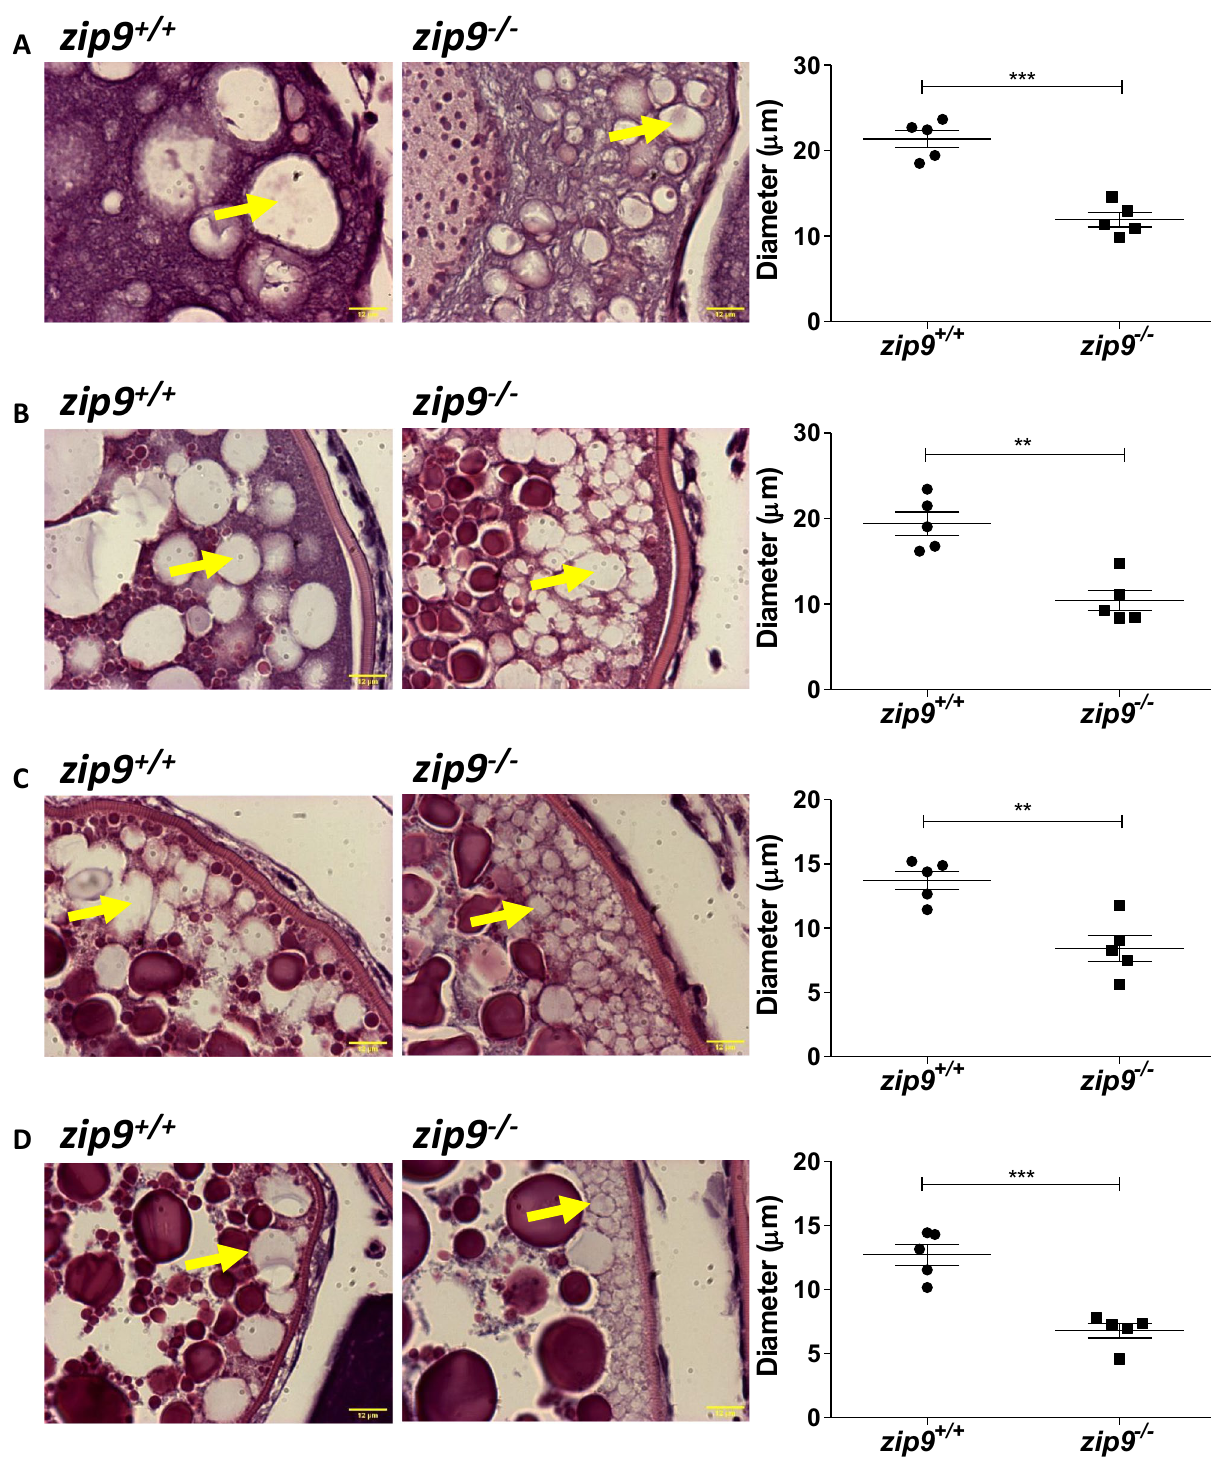
Figure 3. Morphology of cortical vesicles of zip9 + / + and zip9 -/- oocytes throughout oogenesis. Representative images and average cortical vesicle diameters of (A) cortical alveoli, (B) early vitellogenic, (C) mid vitellogenic, and (D) late vitellogenic stage zip9 + / + and zip9 -/- oocytes. Arrows indicate location of cortical vesicles. Scale bars: 12 µm. All data represents means ± SEM; n = 5 (average diameter of cortical vesicles for 5 females). Significance was determined by Welch’s t -test (**, P < 0.01; ***, P <